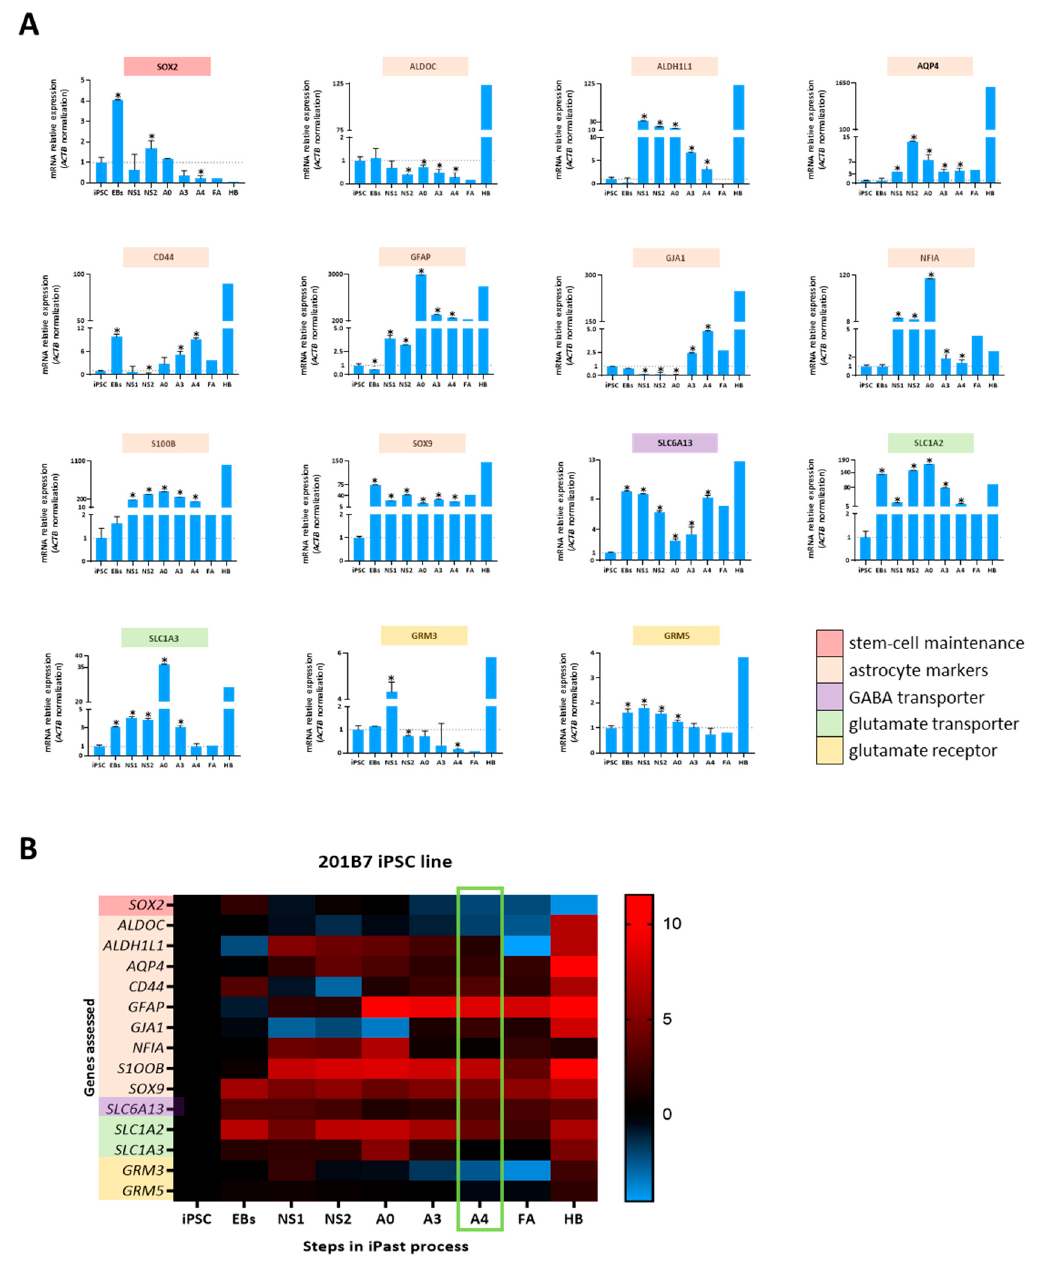
Figure 3. Longitudinal Analysis by Quantitative PCR During iPast Induction Protocol. ( A ) Quantitative real-time polymerase chain reaction of indicated markers in cells derived from the 201B7 iPSC line. Markers are arranged by family according to the indicated color code (stem-cell maintenance, astrocyte markers, GABA transporter, glutamate transporters and receptors). FA stands for control fetal astrocytes and HB for human brain. Values are normalized to ACTB quantification and represent the fold change ratio value relative to iPSC value. n = 3 passages in duplicate. Data shown are mean ± SEM. Statistical test used: Wilcoxon Matched-pairs test. * indicates p -value ≤ 0.05 ( B ) Heatmap summing up gene transcription by quantitative RT-PCR in A. iPasts A4 status is highlighted by the green box. Values are logarithm to base 2 of fold changes from A.